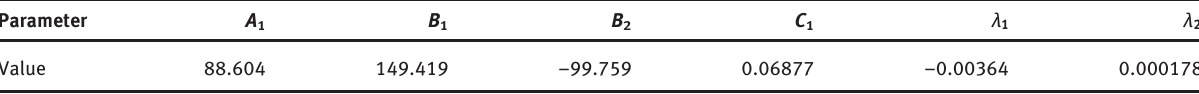
Table 4: Parameters of the M-JC model for BFe10-1-2 cupronickel alloy. Parameter